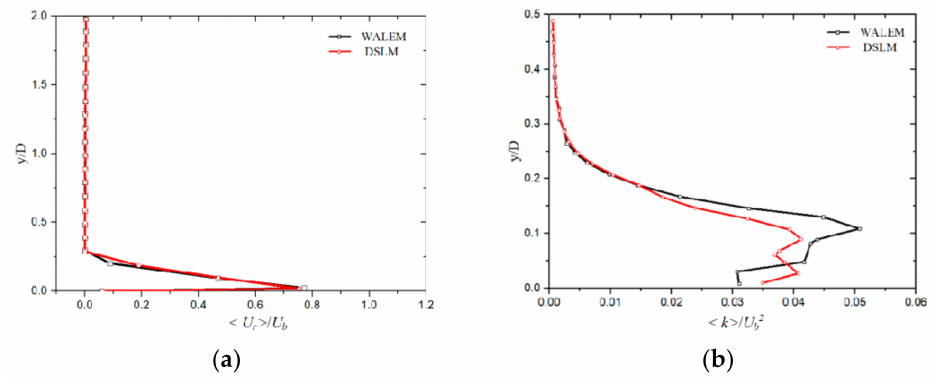
Figure 2. ( a ) Mean radial velocity and ( b ) turbulent kinetic energy at r/D = 2. = 1 According to the criteria presented by Celik et al. [27], when the index s ν t 1 + ν / (cid:104) (cid:105) is equal to 1, it is not sensitive to grid resolution since it is anticipated that ν ν t (cid:105) (cid:29) (cid:104) ν ν is (cid:101) in most LES applications. That is, the LES is better resolved as the value of t (cid:105) / (cid:104) smaller. Celik et al. [27] suggested that LES is considered to be good if the index of quality (LESIQ ν = 1 ) is greater than 0.8. Figure 3 shows the wall-normal ν t 1 + 0.05 ( 1 + / ν ) 0.53 (cid:104) (cid:105) distribution for the ratio of the sub-grid viscosity to the molecular viscosity at r / D = 0 and r / D = 1. It is found that the index of LESIQ ν varies between 0.933 and 0.952 for the ν ν near the wall compared to two turbulence models and the WALEM have littler t (cid:105) / (cid:104) the